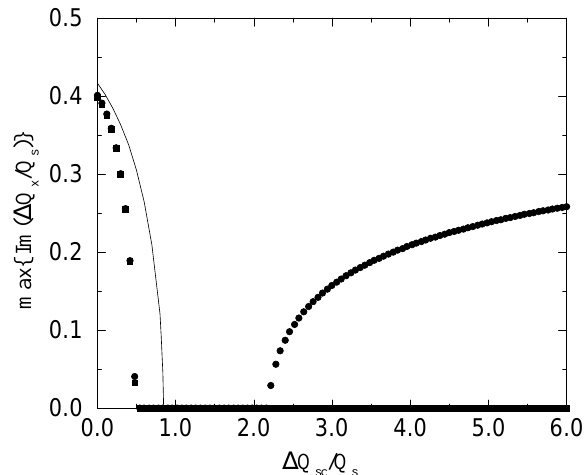
FIG. 1. Largest value of Im (cid:115) D (cid:81) (cid:120) (cid:121) (cid:81) (cid:115) (cid:100) as a function of D (cid:81) (cid:115)(cid:99) (cid:121) (cid:81) (cid:115) and (cid:109) max using matrix element (12). The value of (cid:87) is twice the size needed to produce instability with D (cid:81) (cid:115)(cid:99) (cid:173) (cid:48) : (cid:109) max (cid:173) (cid:49) , solid line; (cid:109) max (cid:173) (cid:53) , squares; (cid:109) max (cid:173) (cid:49)(cid:48) , circles.